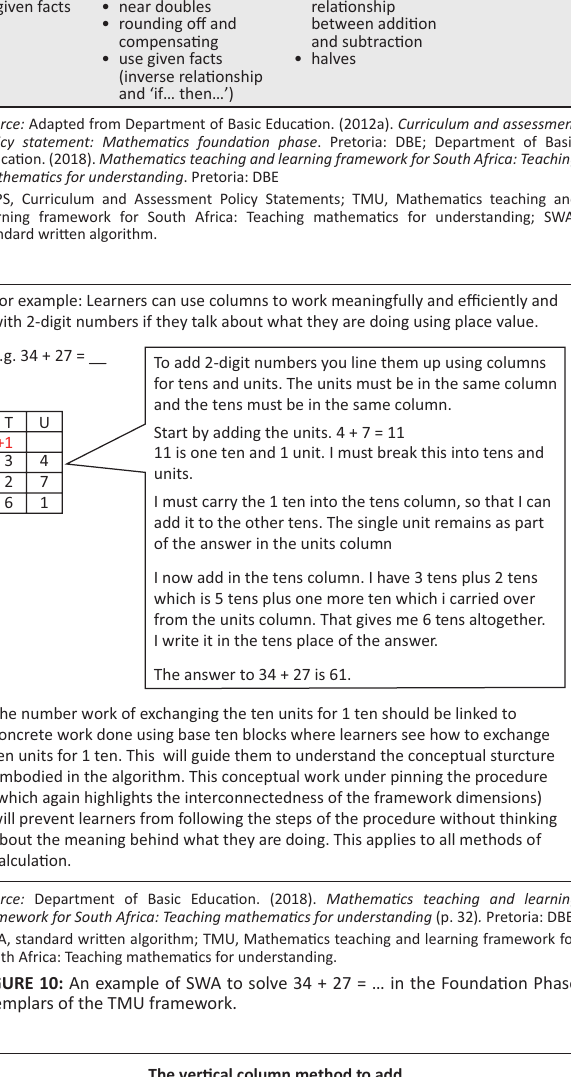
The ver(cid:25)cal column method to